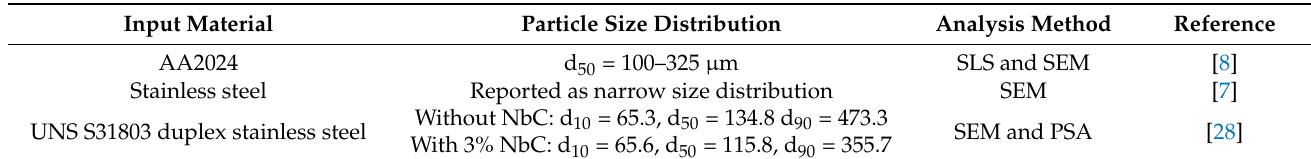
Table 2. Particle size